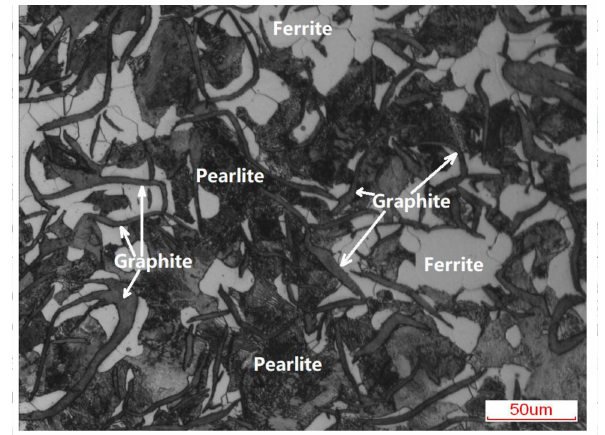
Figure 2. Optical microstructure of the grey cast iron substrate.